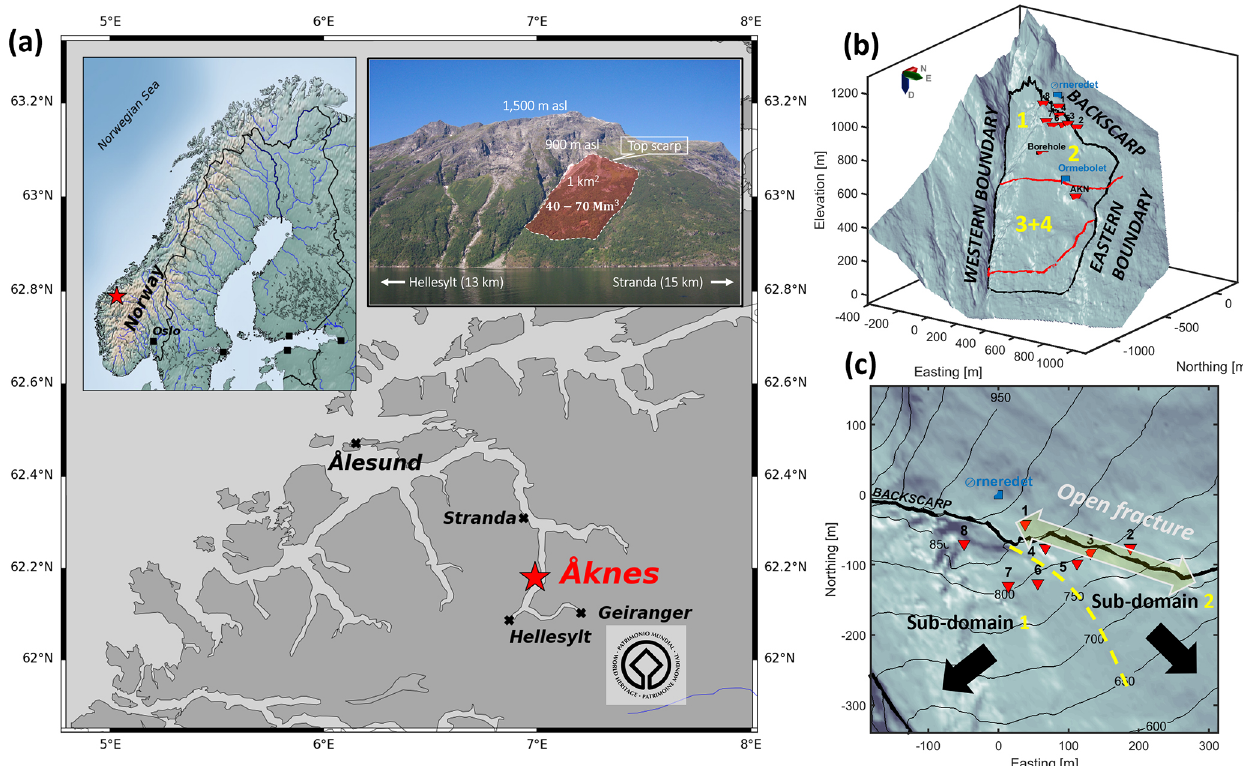
Figure 1. (a) Åknes rockslide location in Western Norway (red star). The photo at the top right shows the Åknes slope seen from the opposite side of the fjord (Roth and Blikra, 2010). The red shaded area represents the unstable area. Digital elevation model of the slope in 3D (b) and map view (c) , zoomed to the top scarp, where the eight surface geophones are placed (red reversed triangles). The two main bunkers at the top and in the middle of the slope are displayed as blue squares. We use a local coordinate system centred on the upper bunker (Ørnereiret). In (b) , the black contour delimits the whole area that could potentially collapse into the fjord. The red lines highlight two of the sliding planes. Sub-domains are indicated by yellow numbers. In (c) , the back scarp splits the network in two, with geophones 1 and 2 placed on the stable ground behind the back scarp. The open fracture is highlighted by the yellow double arrow. The 50m spaced elevation contours are also plotted. The two black arrows indicate the approximate displacement direction in sub-domains 1 and 2, and the dashed yellow curve marks the separation between the two